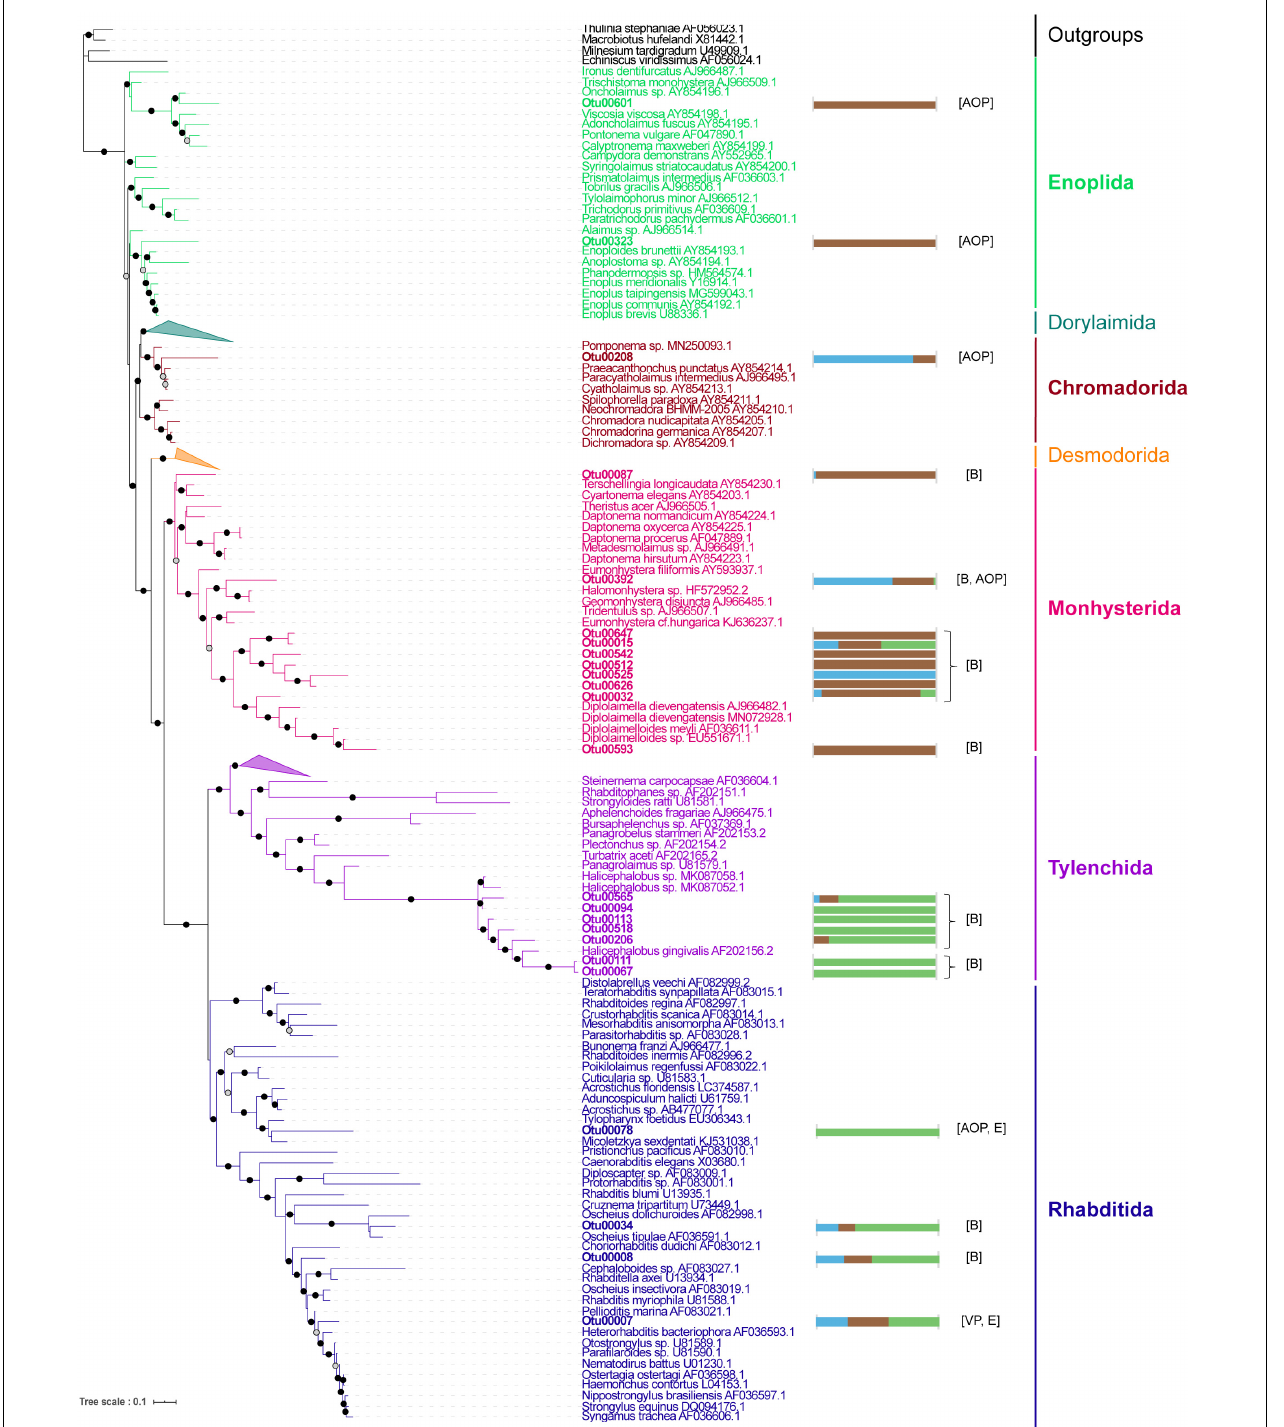
FIGURE 4 | Phylogenetic relationships between the most abundant nematode OTUs associated with Sargassum . The maximum likelihood phylogenetic tree was constructed with PhyML v3.0 using the GTR + G + I model. Branch supports were calculated using a Chi2-based parametric approximate likelihood-ratio test and are represented by black circles for values above 0.90 and gray circles for values between 0.7 and 0.89. OTU sequences are in bold. The horizontal bar plots represent the normalized total abundance of each OTU in the different compartments: TS-sw in blue, TS-sarg in brown, and ISS-sarg in green. Putative trophic groups were assigned following recommendations by Meldal et al. (2007): algivore-omnivore-predator (AOP), bacterivore (B), entomopathogen (E), and vertebrate parasite (VP).